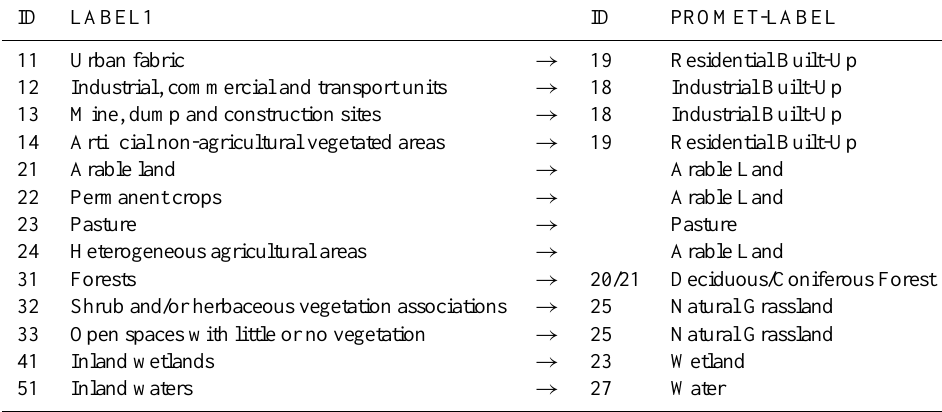
Table 3. Transformation of the CORINE Land Cover 1990 Switzerland into the PROMET classes.